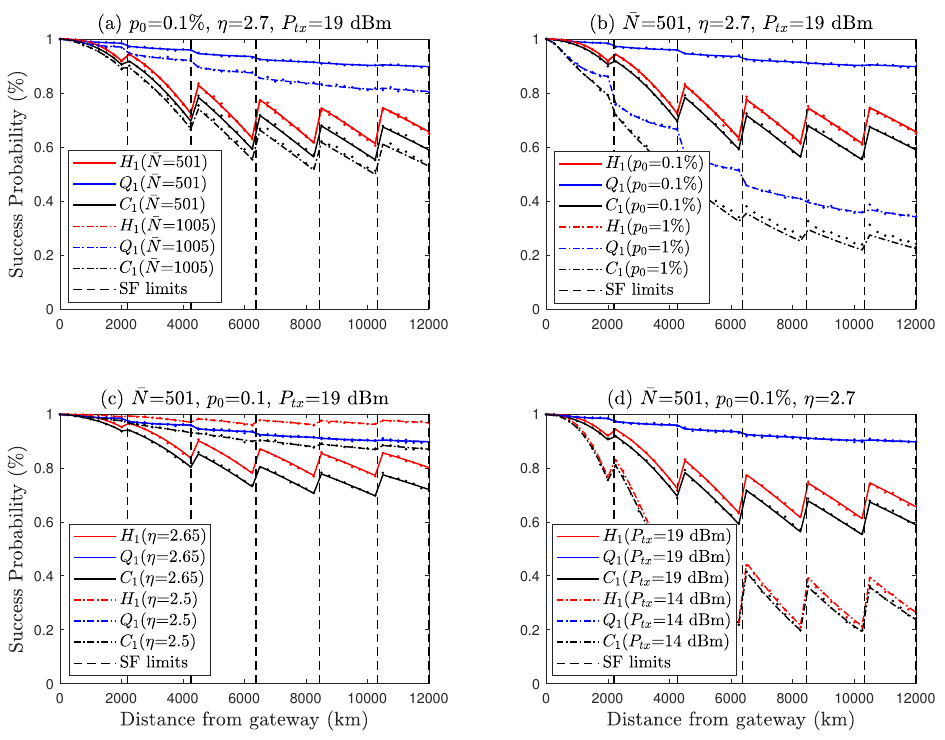
Figure 10. Performance LoRa uplink considering Fibonacci series K-means clustering, and the impact of different parameters on success probabilities. ( a ) Density of users increased from ¯ N = 501 to ¯ N = 1005. ( b ) Duty cycle increased from p 0 = 0.1% to p 0 = 1%. ( c ) Path loss exponent from η = 2.5 to η = 2.65. ( d ) Transmit power from ( P tx = 14) dBm to P tx = 19